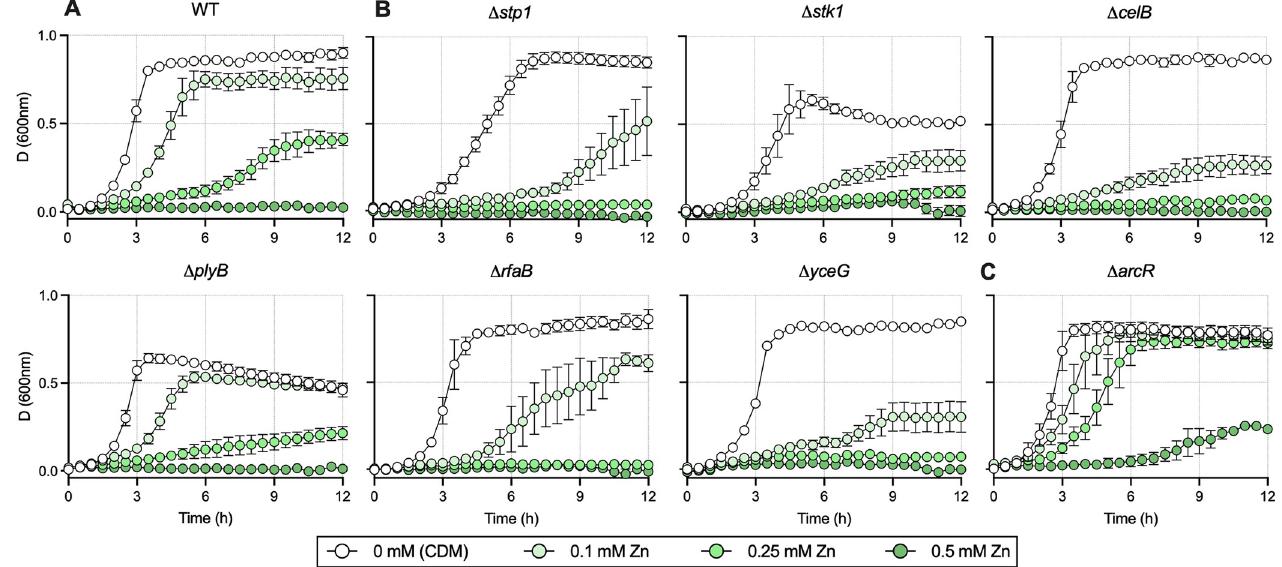
Fig 11. Validation of TraDIS hits by isogenic mutation and phenotypic comparisons for selected genes of the Zn stress resistomes. WT GBS (A) and mutants with deletions in genes identified as important during in Zn intoxication by TraDIS (B-C) were examined for growth phenotypes in CDM (a nutrient- limited medium) or CDM supplemented with 0.1, 0.25 and 0.5mM Zn as indicated. Points show means of attenuance (600nm) and bars show s.e.m. ( n �